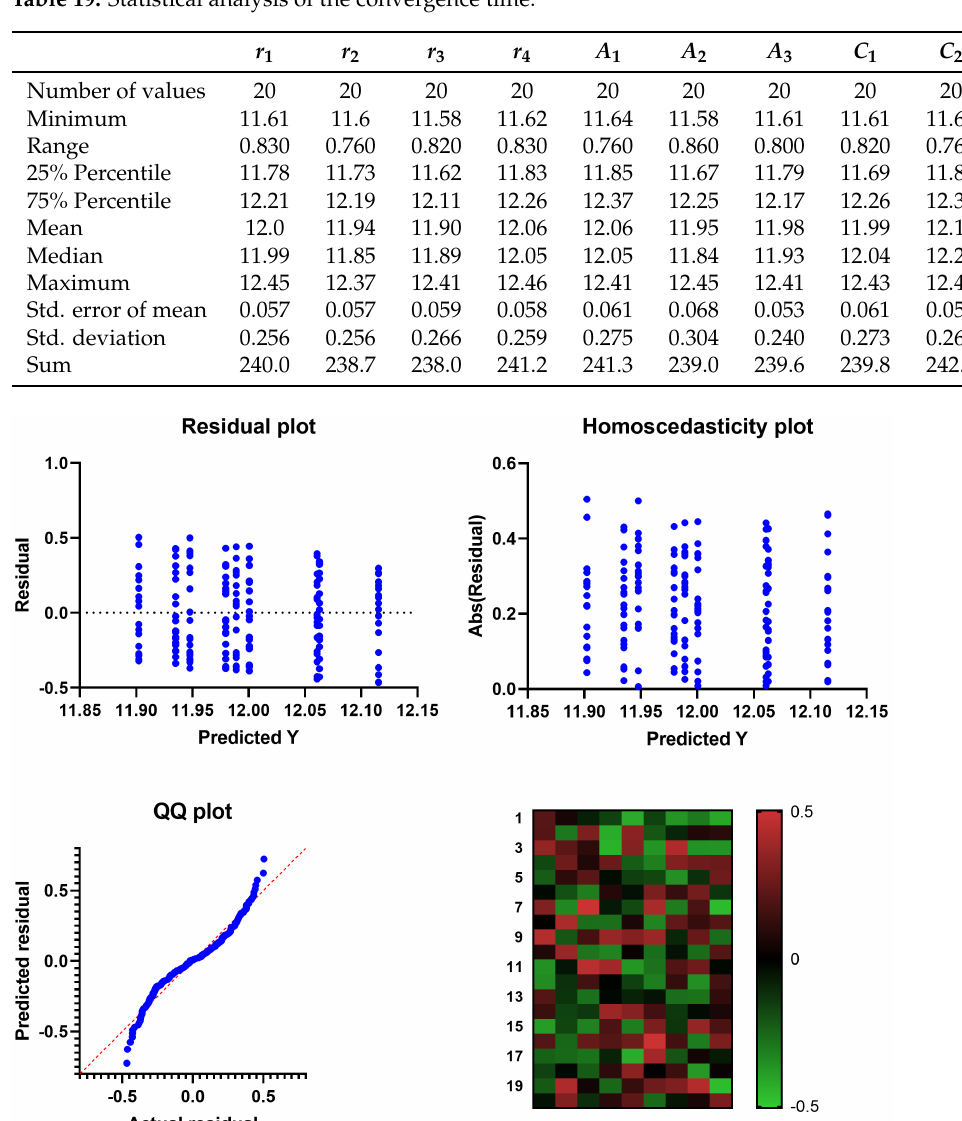
Table 19. Statistical analysis of the convergence time.